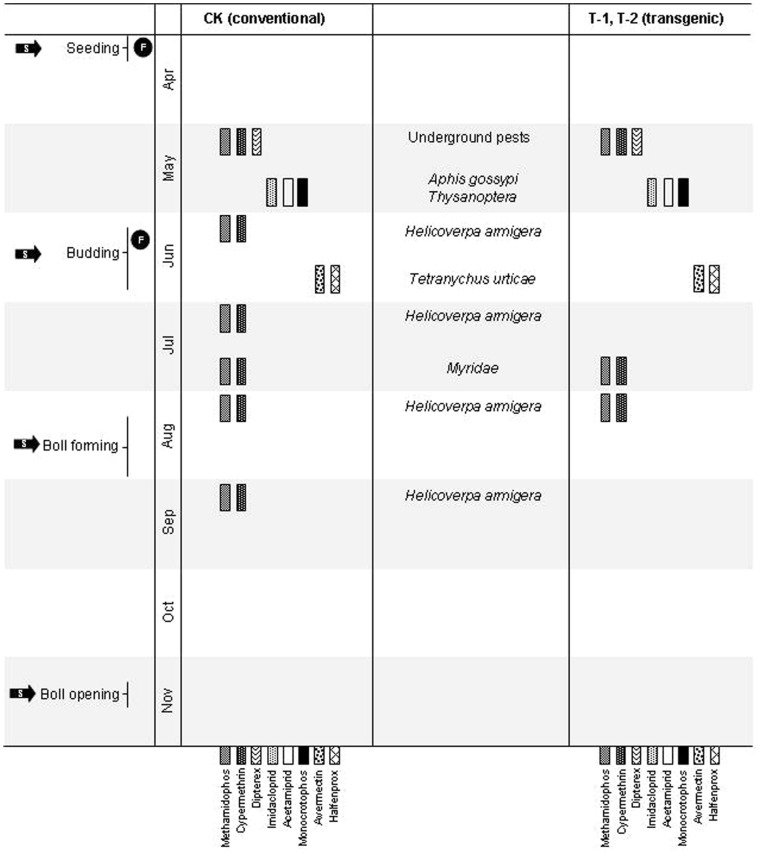
Schematic of agricultural practices applied to the 3 cotton fields during this study (2007–2010).Patterned bars represent different pesticides, with target pest listed in central column. Black circles with ‘F’ indicate fertilizer application, and black arrows with ‘S’ represent sampling times. Symbol placement is indicative of timing but is not precise.